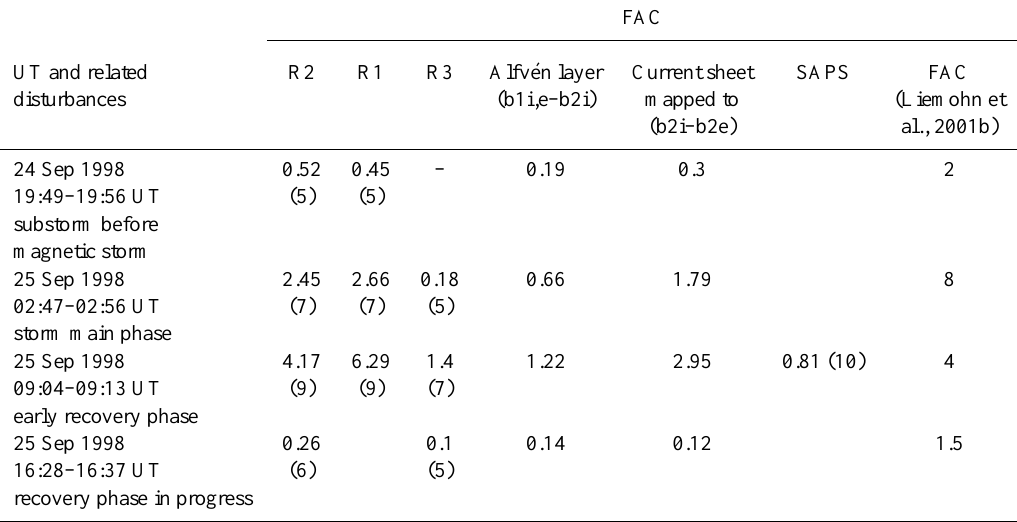
Table 2. The total FAC intensity (MA) during different phases of a magnetic storm. The longitudinal extent (hours) of the corresponding FAC-regions (R1 – Region 1, R2 – Region 2, R3 – Region 3) is indicated in brackets.